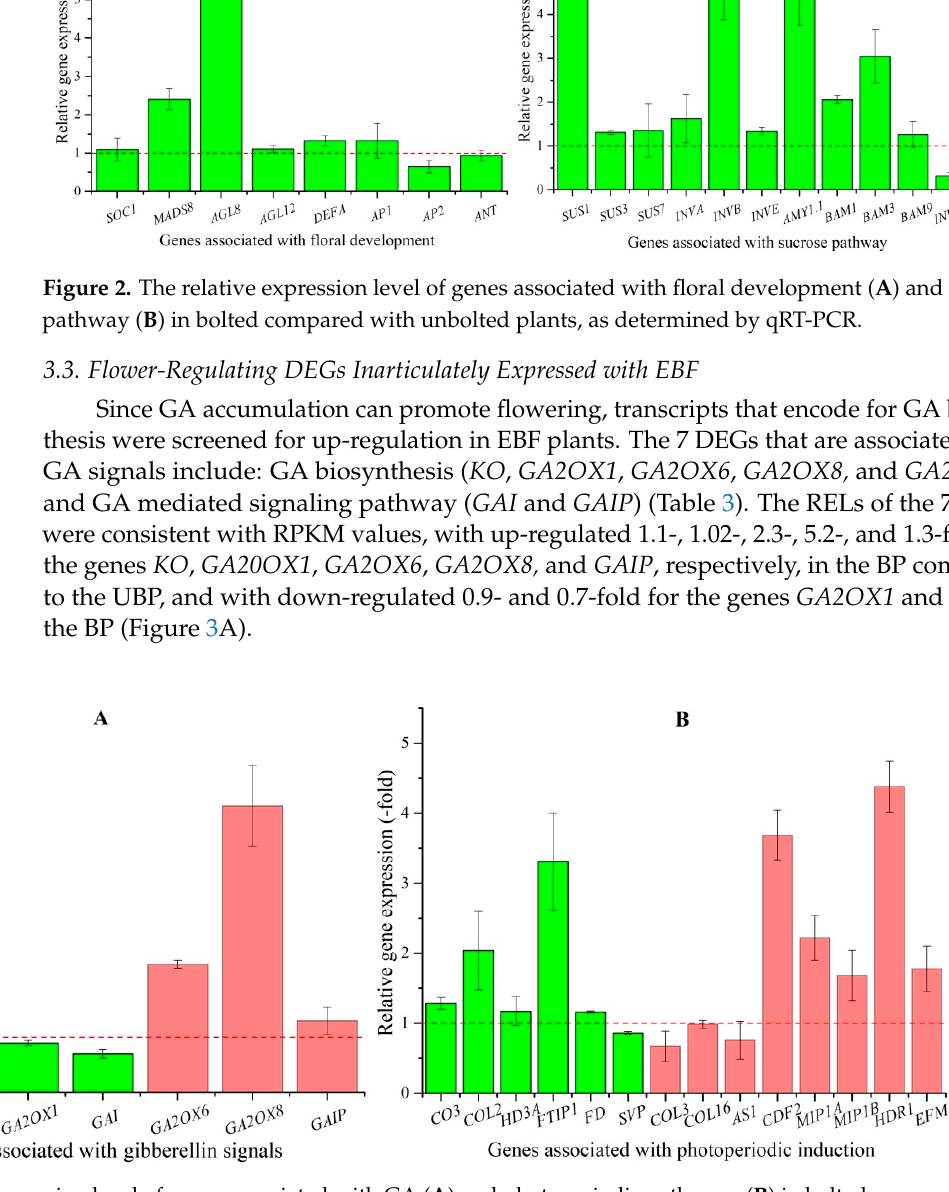
Figure 4. The contents of GAs ( A ) and soluble sugar ( B ) in bolted and unbolted plants, as determined by HPLC-MS/MS. An asterisk (*) represents a significant difference ( p < 0.05) between BP and UBP. 4. Discussion The SUPPRESSOR OF OVEREXPRESSION OF CONSTANS1 ( SOC1 ) can integrate signals from the photoperiodism, vernalization, sucrose and GA pathways and regulate the expression of LFY , which links floral induction and floral development, when associ- ated with other MADS box genes [35]. MADS box proteins regulate different develop- mental processes including flowering time, floral meristem identity, and floral organ de- velopment [36]. MADS8, which is structurally related to the AGL2 family, is involved in